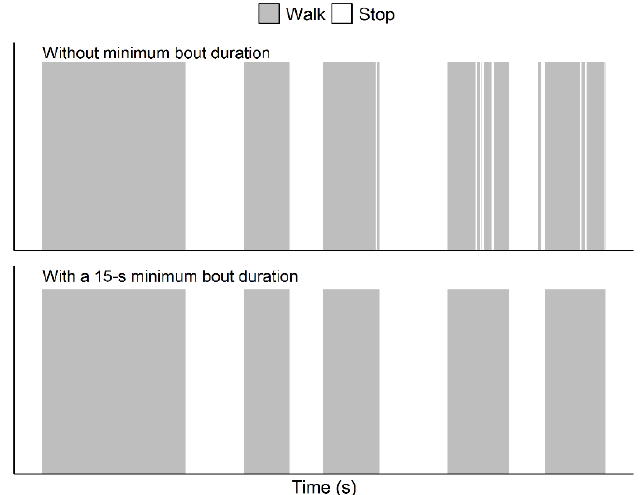
Figure 2. Illustration of the use of the 15-s minimum bout duration to detect the walking and stopping bouts during the evaluation of outdoor walking capacities using GPS.